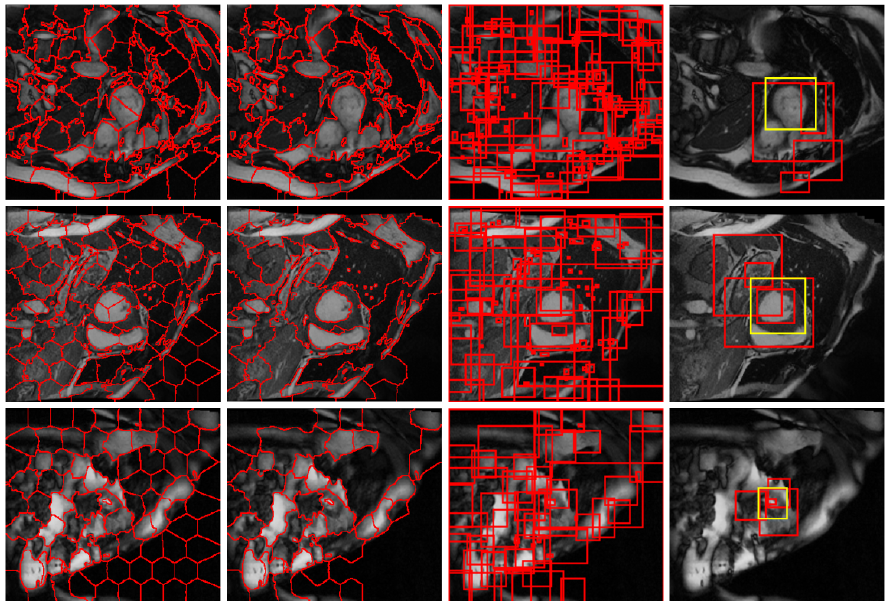
Figure 2. Procedure of our region proposal generation. From left to right: initial structural similarity-enhanced supervoxels; merged supervoxels by hierarchical clustering; corresponding bounding boxes; final top-level region proposals where yellow rectangles denote ground